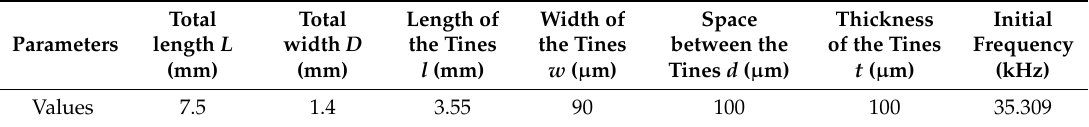
Table 1. Dimensions of structural parameters of DETF.